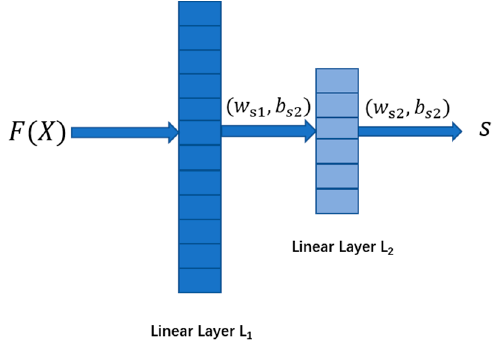
Figure 5. The score-guided network structure of this paper.